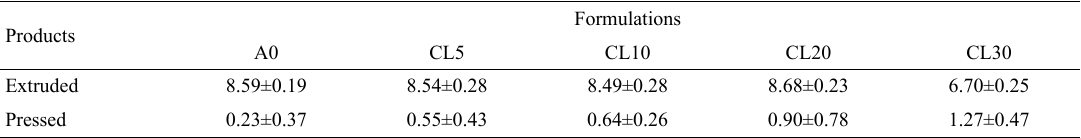
Table 3. Results of drying linear shrinkage for the extruded and pressed products.